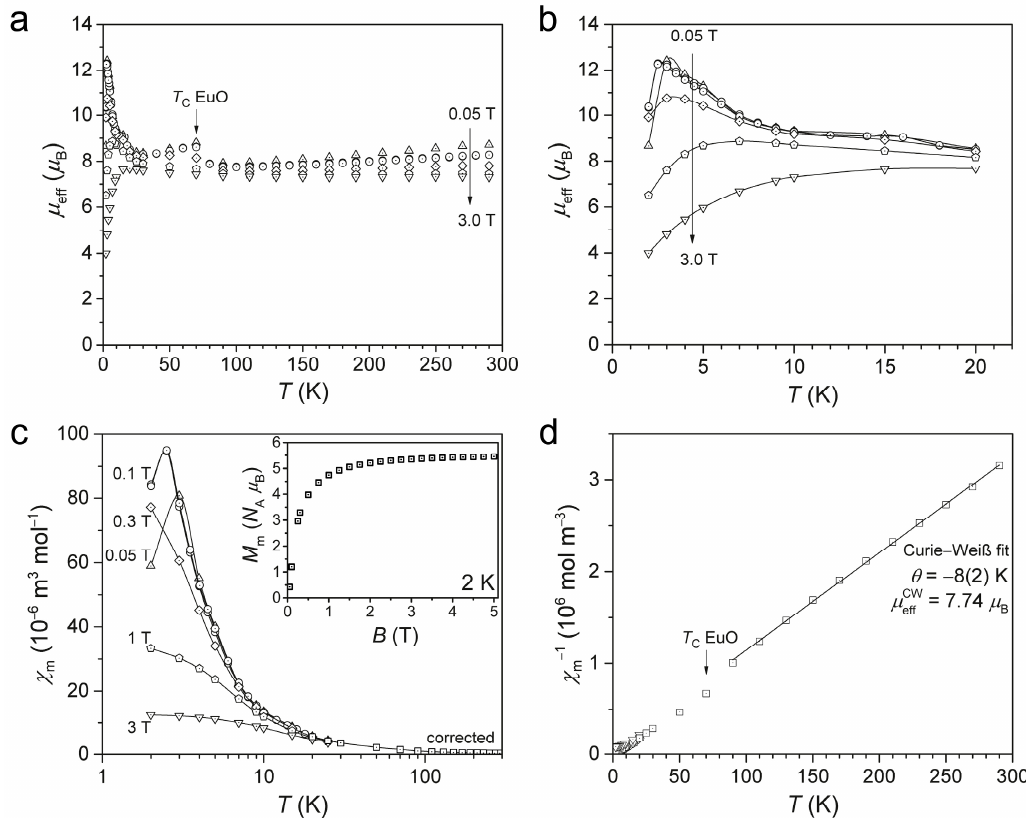
Figure 7. Effective magnetic moment ( a ) vs temperature for α -Eu(CN 3 H 4 ) 2 at different applied fields; effective magnetic moment in more detail ( b ) revealing ferromagnetic exchange interactions (lines in ( b ) and ( c ) as guide to the eye only). Molar, corrected magnetic susceptibility ( c ) vs temperature for different applied fields; inset: magnetization versus applied field at 2.0 K. Corrected inverse molar susceptibility ( d ) vs temperature, and fit to the Curie–Weiss law.